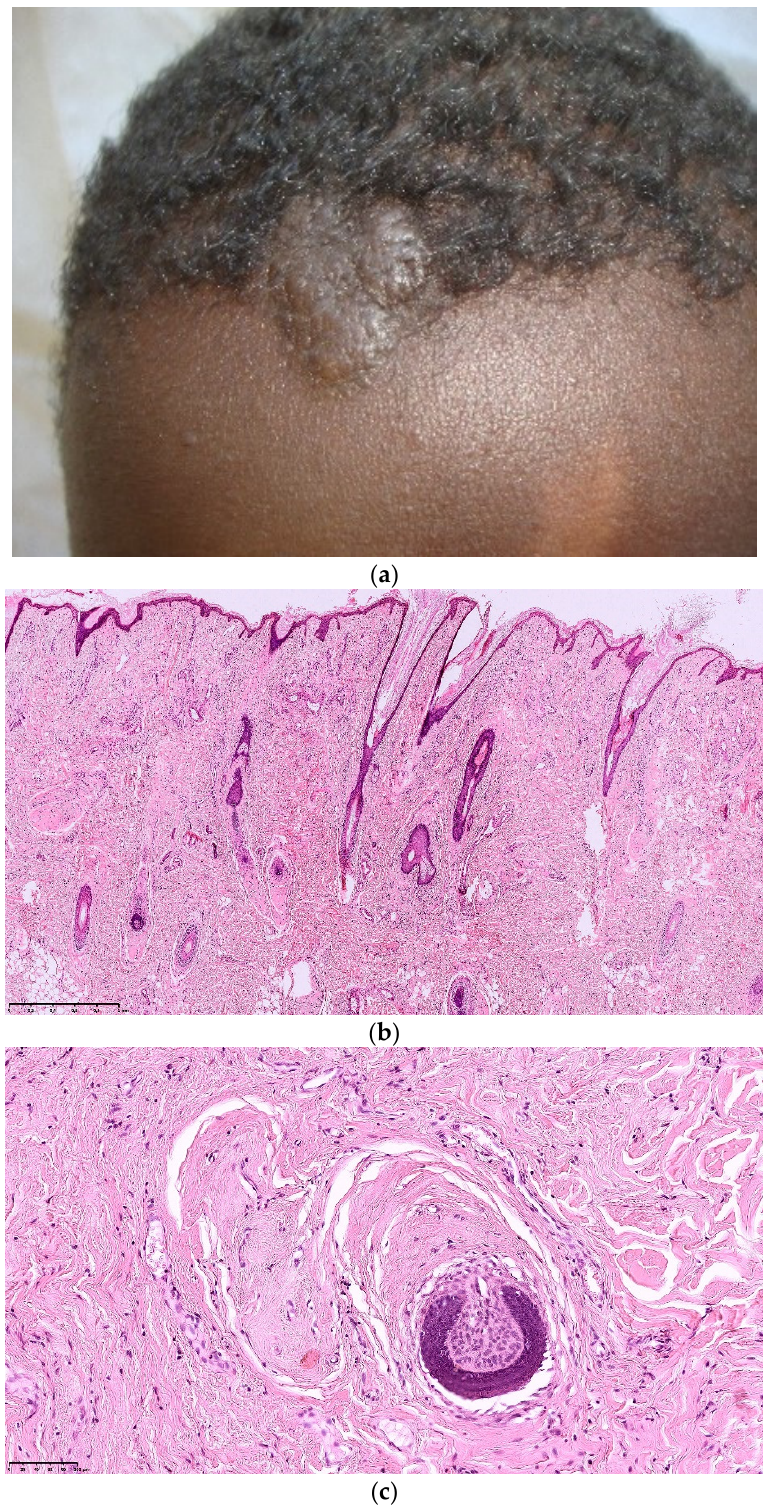
Figure 4. Fibrous cephalic plaque. ( a ): Clinical aspect of a fibrous cephalic plaque of the forehead; ( b ): Hematein eosin ×10: dense proliferation of collagen bundles in the dermis and the hypodermis; ( c ). Concentric perifollicular fibrosis leading to atrophy and compression of the follicle.